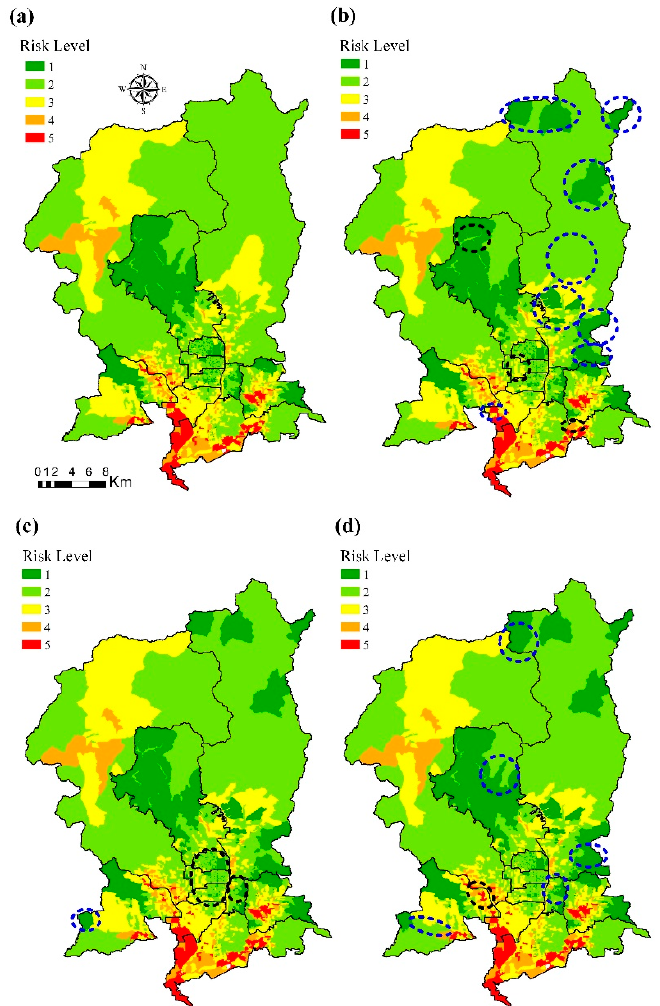
Figure 9. Climate risk maps with the possible situations of exposure and vulnerability during ( a ) 2015, ( b ) 2020, ( c ) 2025, and ( d ) 2030. Note: The blue and black dotted circles mean the risk levels decrease and increase compared to the previous year, respectively.